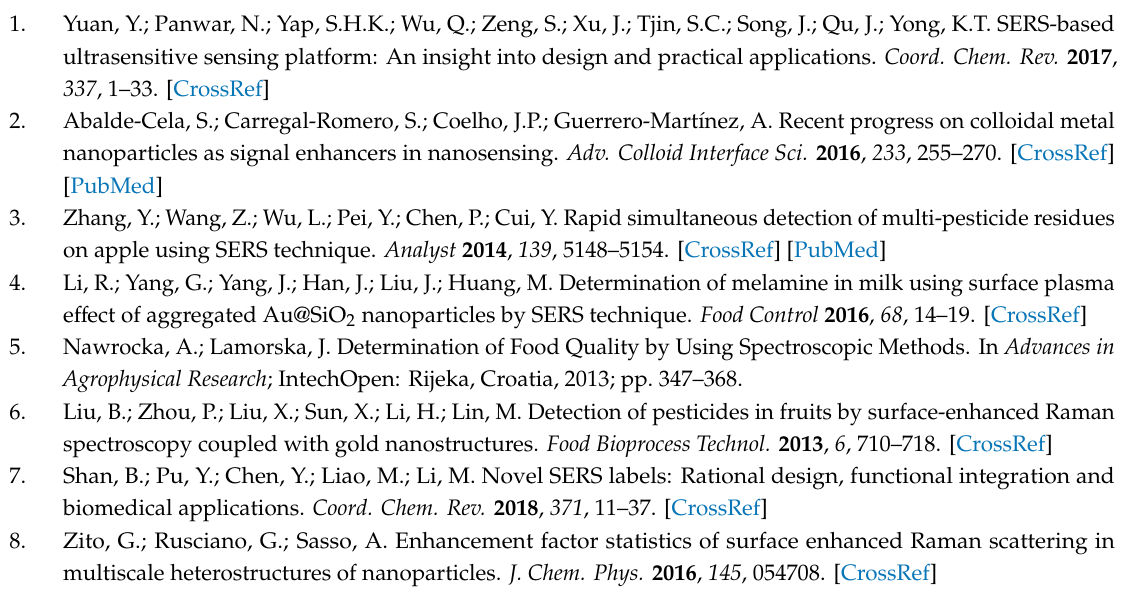
Figure S1: SERS spectrum of Cypermethrin at a concentration of 10 − 3 M, taken with a 633 nm-wavelength laser. The peaks at 662, 1002, 1165, 1208, 1615, 1740, and 2253 cm − 1 corresponds to